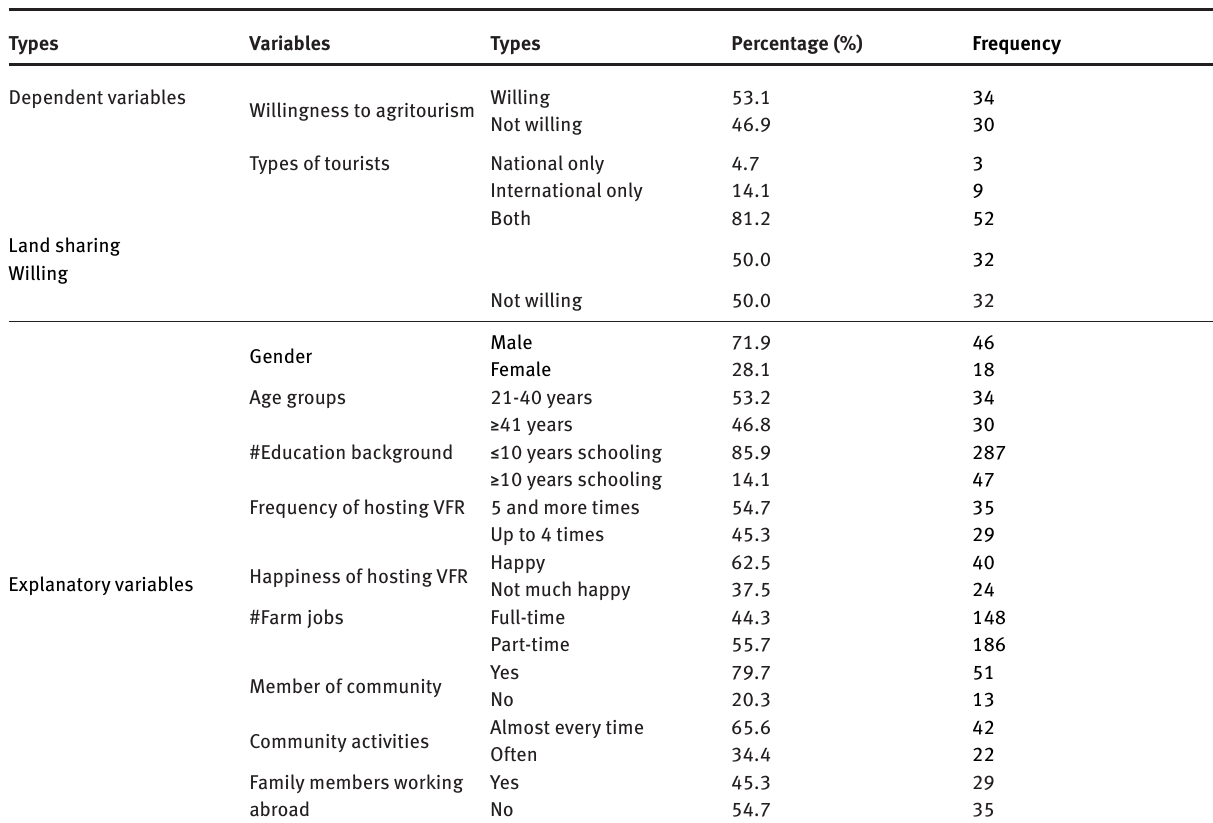
Table 2: Summary Statistics of variables